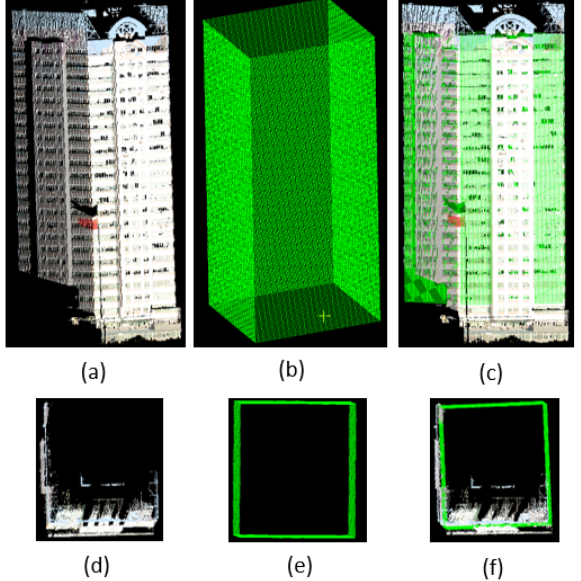
Figure 6: Point cloud C 4 (left), model M 4 (middle), and the over- lapping of C 4 and M 4 (right).